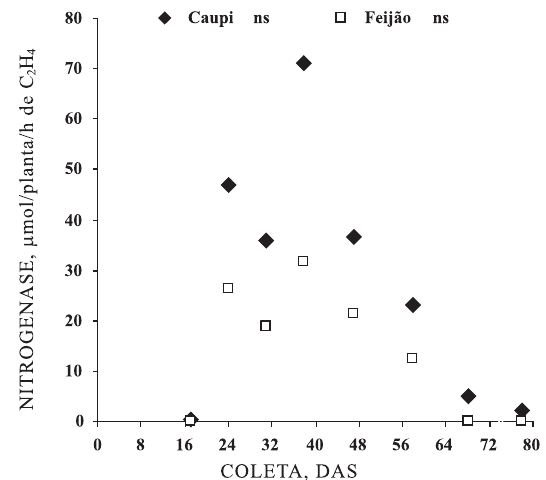
Figura 2. Atividade da enzima nitrogenase (redução do C H ) em feijão-comum e feijão-caupi em 2 2 função de diferentes épocas de coleta. ns: não